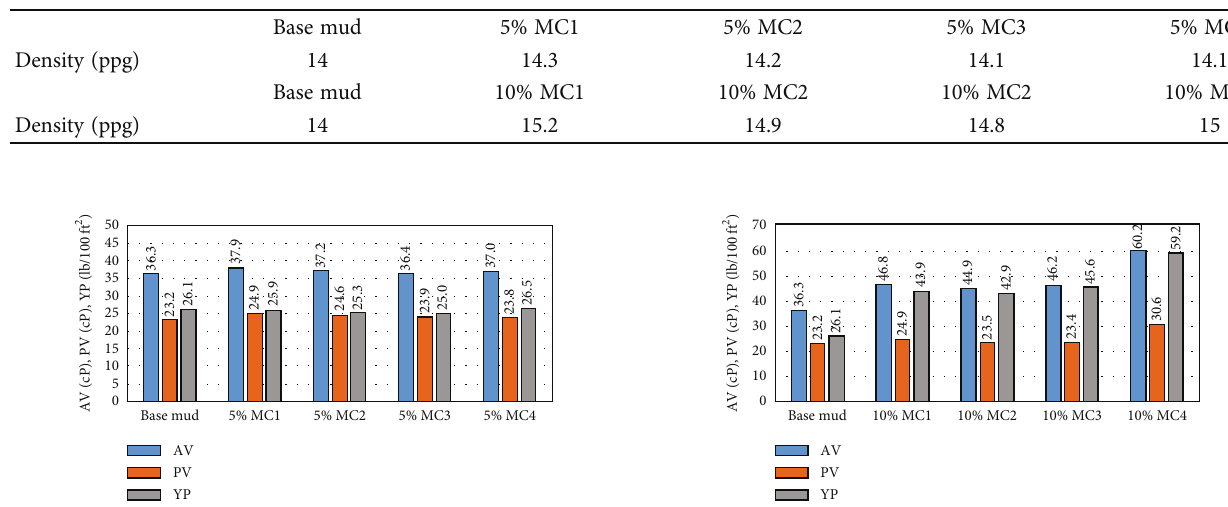
Table 3: The density of the drilling fl uids.